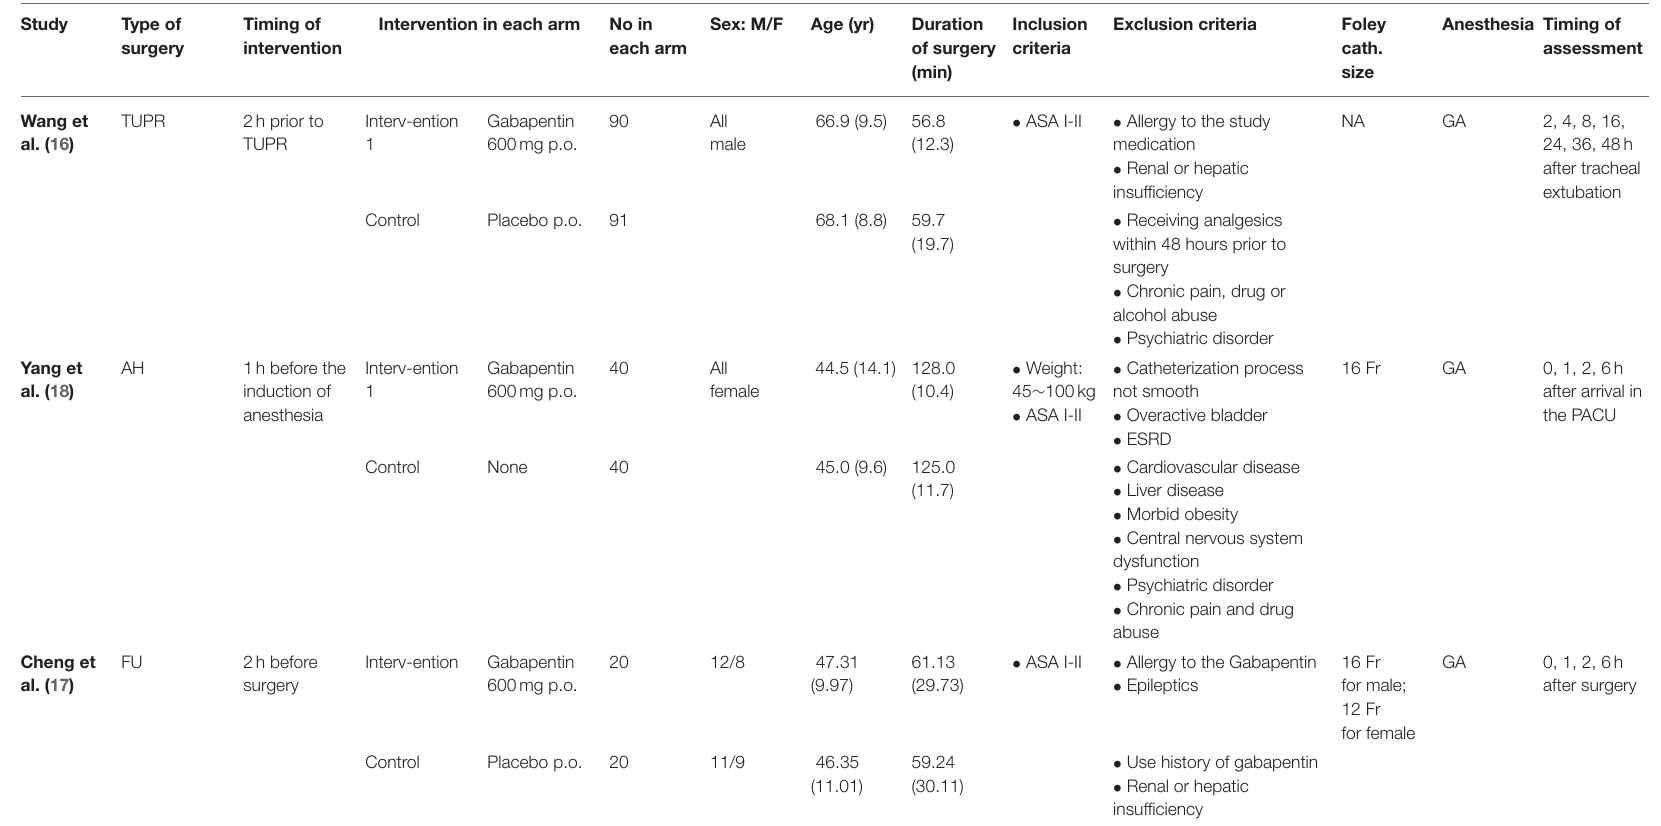
Values are shown as mean (standard deviation) or median (interquartile range) or number. PCNL, percutaneous nephrolithotomy; ASA, American Society of Anesthesiologists; TURP, transurethral resection of the prostate; BPH, benign prostatic hyperplasia; DM, diabetic mellitus; ESRD, End-stage renal disease; GA, general anesthesia; PACU, post-anesthesia care unit; TURBT, transurethral resection of bladder tumor; SA, spinal anesthesia; NA, not available; AH, abdominal hysterectomy; FU, flexible